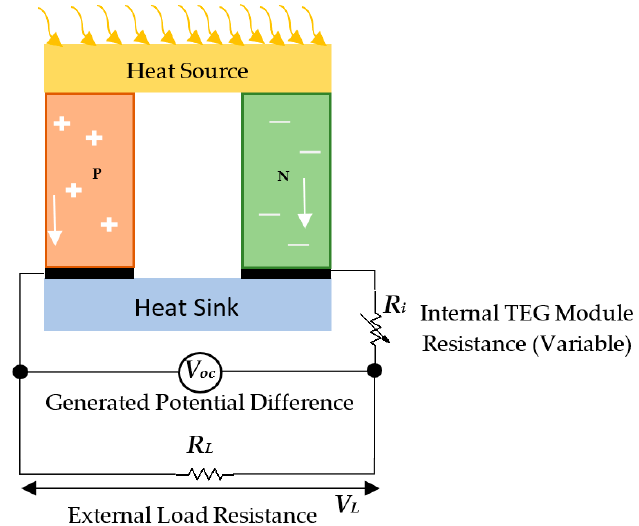
Figure 1. Schematic diagram of thermoelectric generator (TEG) composed of P- and N-type Bi 2 Te 3 composite: one couple is illustrated here; typically, it consists of many couples depending on its size, showing the open circuit-generated voltage ( V oc ) obtained without R L . Full load voltage can be obtained when matched load resistance ( R L ) is connected. The internal TEG resistance ( R i ) is dynamic, due to its dependency on the temperature differentials.